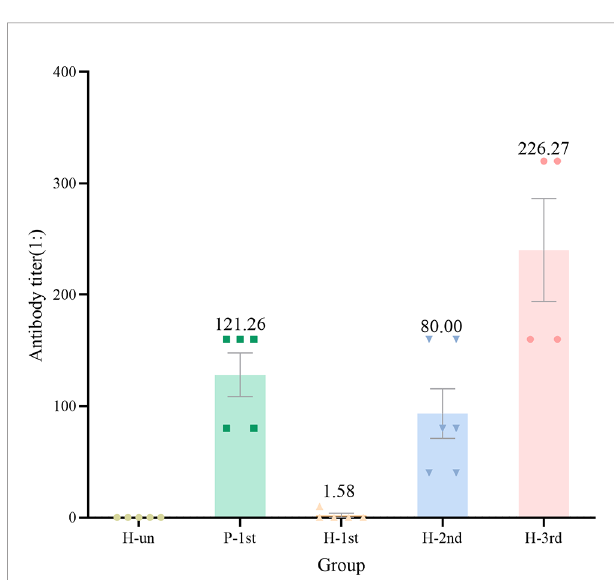
FIGURE 2 | The antibody titer of IgG in the fi ve groups of serum samples. Dots are antibody titres in serum samples. Numbers above the bars are geometric mean